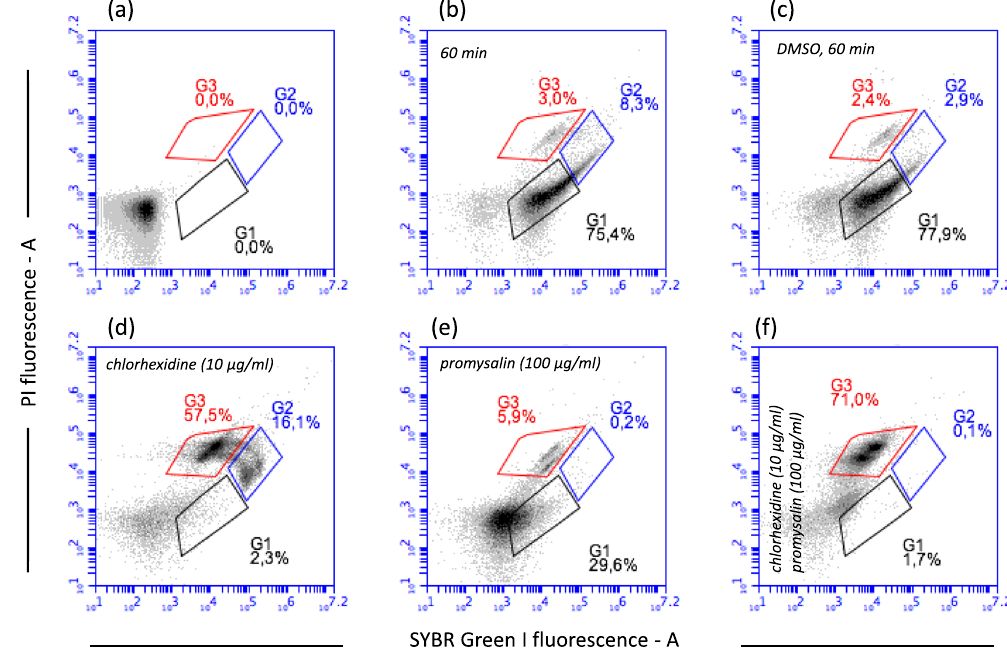
Figure 3. Membrane damage in P. aeruginosa ATCC 10145 exposed to promysalin, chlorhexidine, and to a mixture of the two molecules. Flow cytometry density diagrams show the SYBR Green I vs PI fluorescence of cells exposed to promysalin or chlorhexidine or both the molecules. Viable cells are gated in G1, viable cells with slightly damaged cell membrane are gated in G2. Dead cells with damaged membrane are gated in G3. The transition of cell population from gate G1 to gate G3 is related to the entity of cell membrane damage. ( a ) P. aeruginosa unlabeled cells. ( b ) P. aeruginosa cells incubated 60 min at 37 °C. ( c ) P. aeruginosa cells incubated 60 min at 37 °C in presence of DMSO. ( d ) P. aeruginosa cells incubated 60 min at 37 °C in presence of chlorhexidine